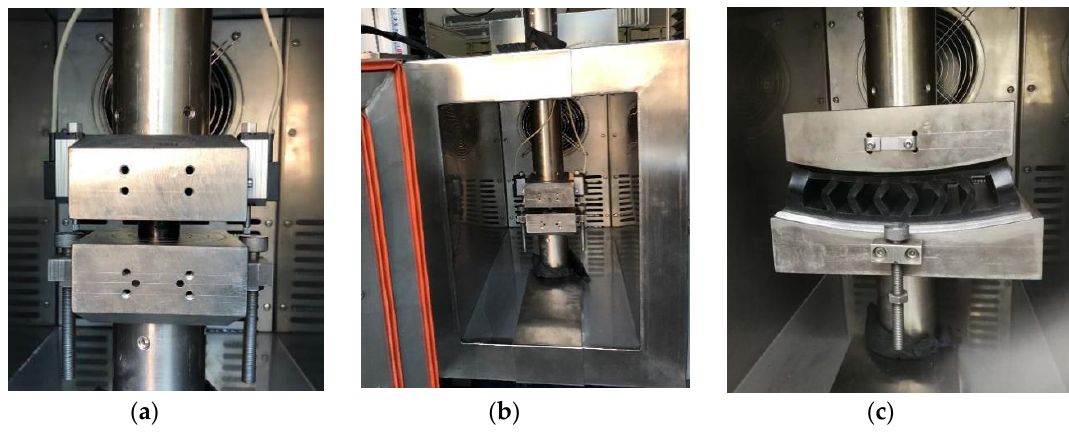
Figure 3. Experimental setup: ( a ) Quasi-static compression of rubber sample, ( b ) creep compression of rubber sample, and ( c ) creep compression of rubber device.